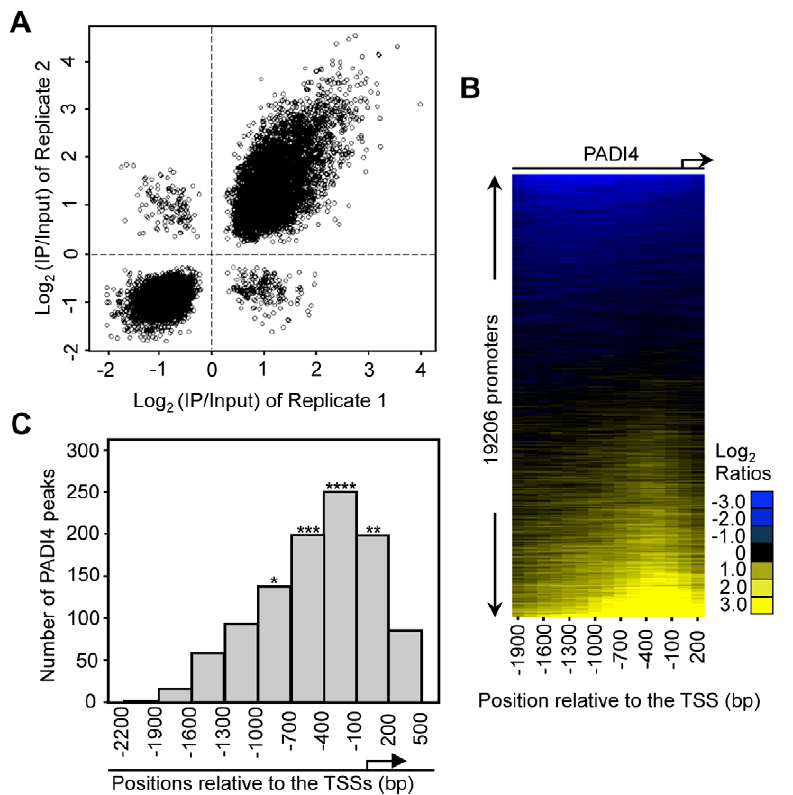
Figure 1. PADI4 is enriched in the gene promoter region near the TSSs. (A) Scatterplot showing the mean log 2 ratio of each window on the array for two PADI4 ChIP-chip replicates. The spearman rank correlation coefficient and associated p-value are indicated. (B) Heat map of PADI4 ChIP- chip data for 19,206 promoters from 2 2,200 bp to + 500 bp relative to the TSS. The values in the x-axis represent the center of a 600 bp window with 150 bp steps relative to each TSS. The promoters are ordered top to bottom based on the increasing intensity of the PADI4 signal at the promoter surrounding the TSSs. (C) Histogram showing the number of statistically significant peaks (Wilcoxon signed-rank test, p , 0.016) across the entire tiled region for all the promoters on the ChIP-chip array. The asterisk denotes significant enrichment of PADI4 peaks near the TSSs based on the p-value from a Fisher exact test (*p=0.0444, **p=0.0085, ***p=6.21 6 10 2 9 , ****p=1.42 6 10 2 15 ).